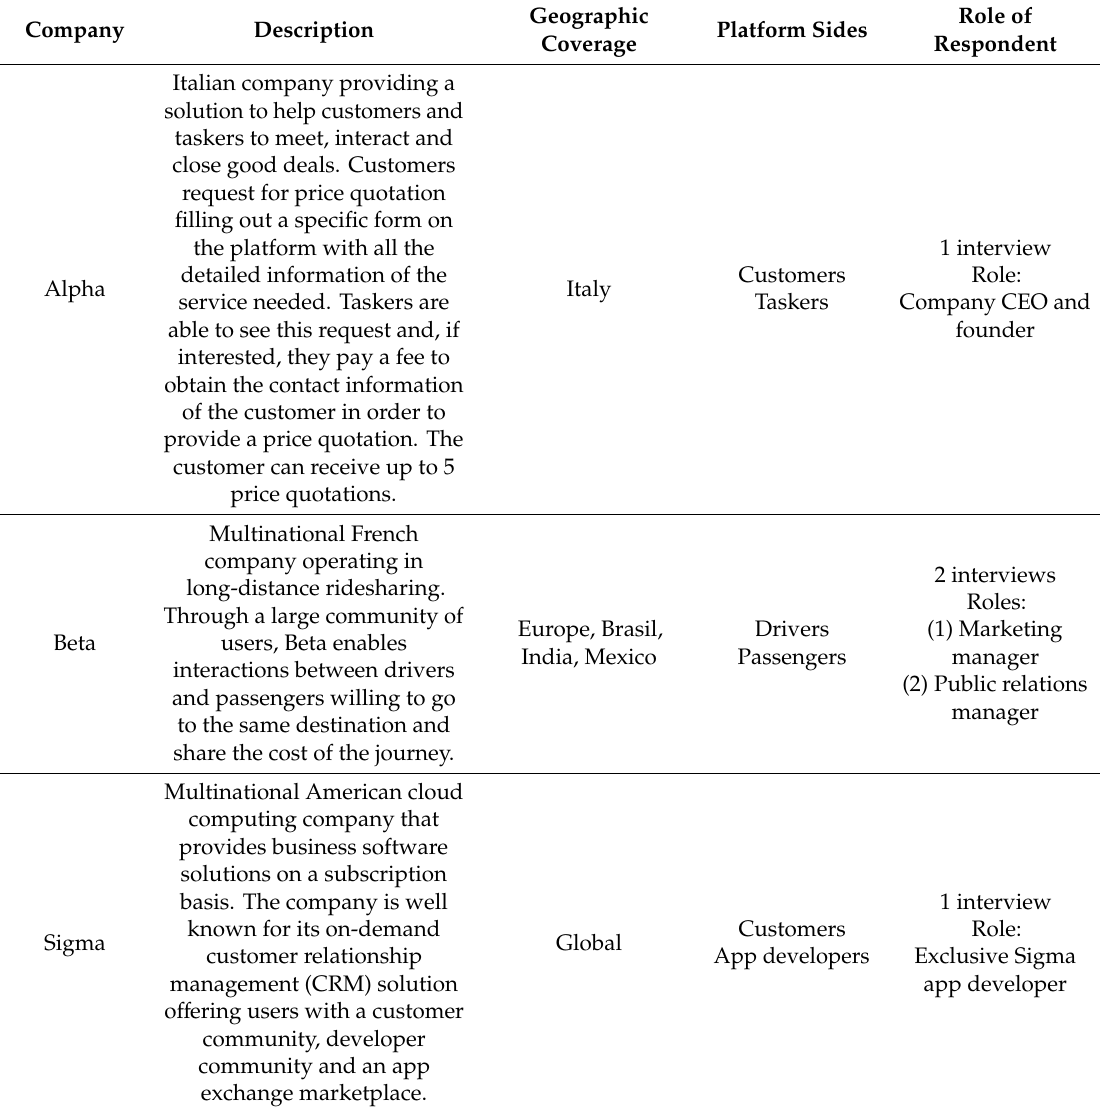
Table 4. Exploratory case: company